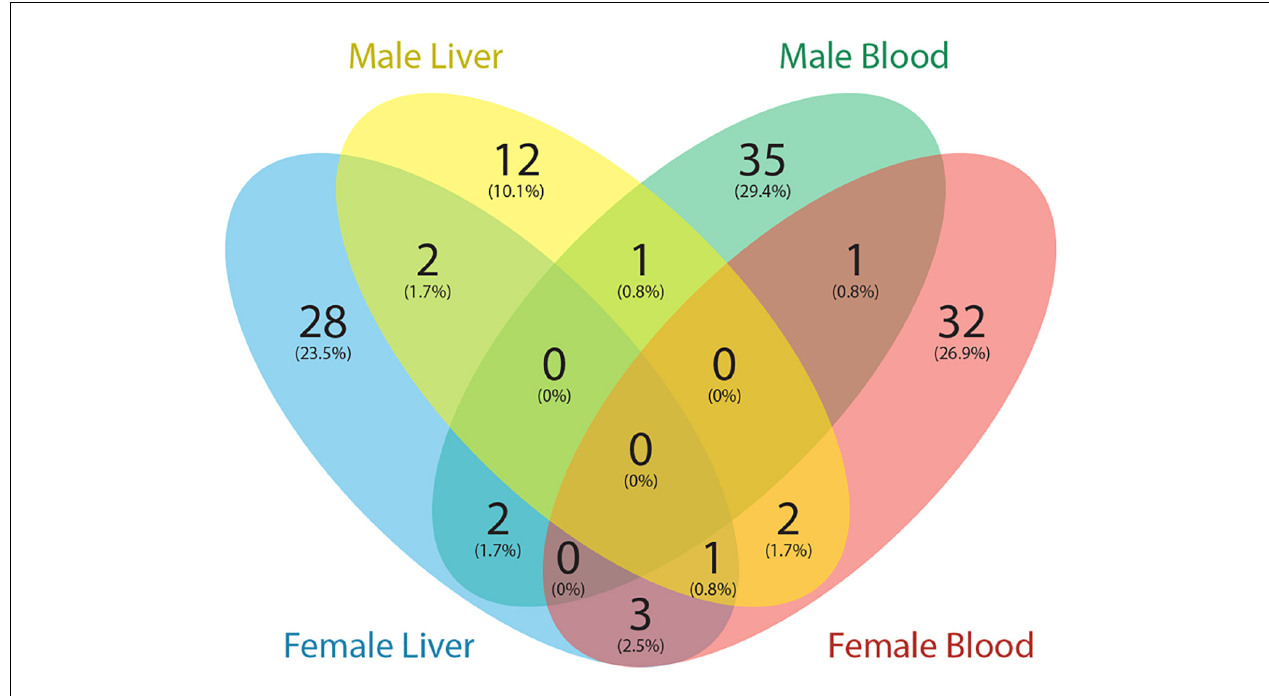
FIGURE 3 | Venn diagram showing the number of genes with DMRs overlapped with Pb exposure related genes from the Comparative Toxicogenomics Database